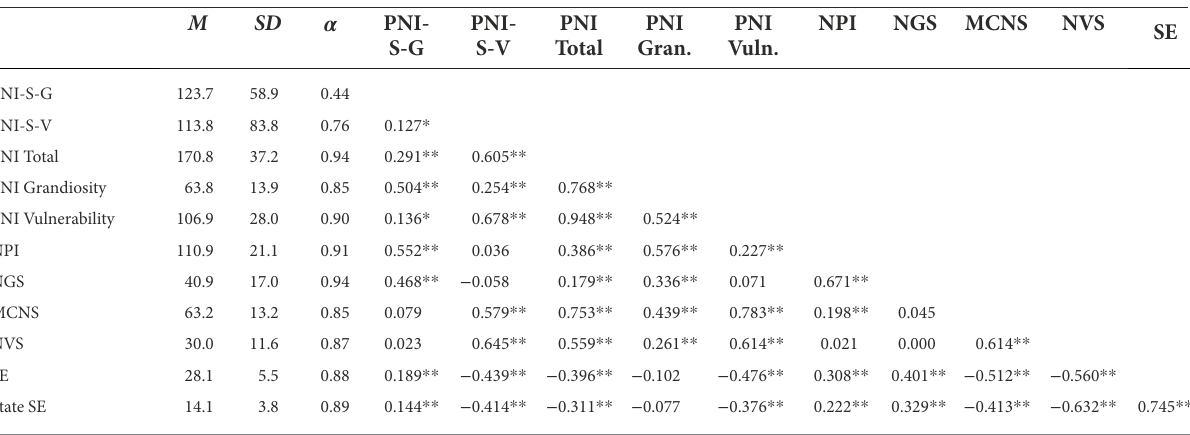
TABLE 2 Descriptive statistics, internal consistency, and associations of all study variables (Sample